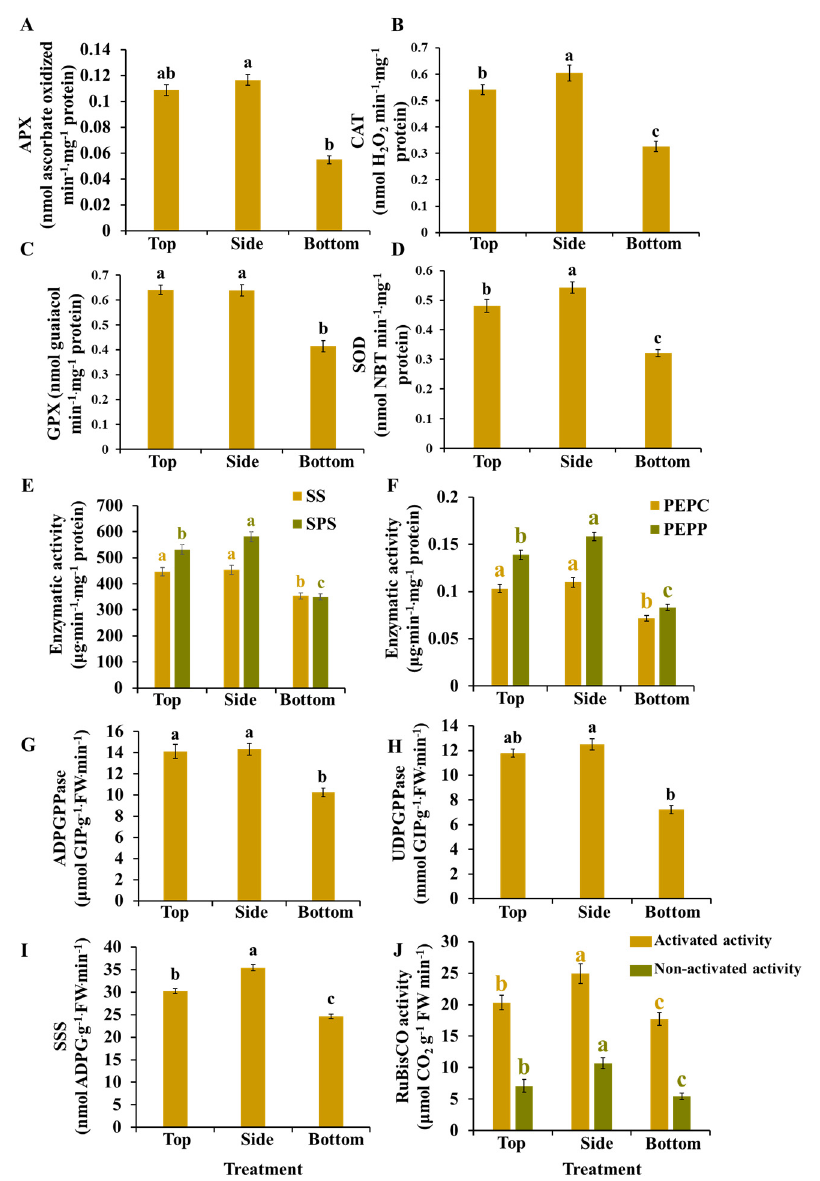
Figure 8. Changes in the enzymatic activities in strawberry ‘Sulhyang’ as affected by the lighting direction after 45 days of cultivation. The ROS scavenging enzymatic activities: Ascorbate peroxidase (APX) ( A ), catalase (CAT) ( B ), guaiacol peroxidase (GPX) ( C ), and superoxide peroxidase (SOD) ( D ). Sucrose synthesis enzymatic activities: Sucrose synthase (SS) and sucrose phosphate synthase (SPS) ( E ), phosphoenolpyruvate carboxykinase (PEPC) and phosphoenolpyruvate phosphatase (PEPP) ( F ). Starch synthesis enzymatic activities: Adenosine diphosphate glucose pyro-phosphorylase (ADPGPPase) ( G ), uridine diphosphate glucose pyro-phosphorylase (UDGPPase) ( H ), and soluble starch synthase (SSS) ( I ). Photosynthesis enzymatic activities: Activated and non-activated activity of RuBisCO ( J ). Vertical bars indicate the means ± standard error ( n = 6). Different lowercase letters indicate significant separations within treatments by Duncan’s multiple range test at p ≤